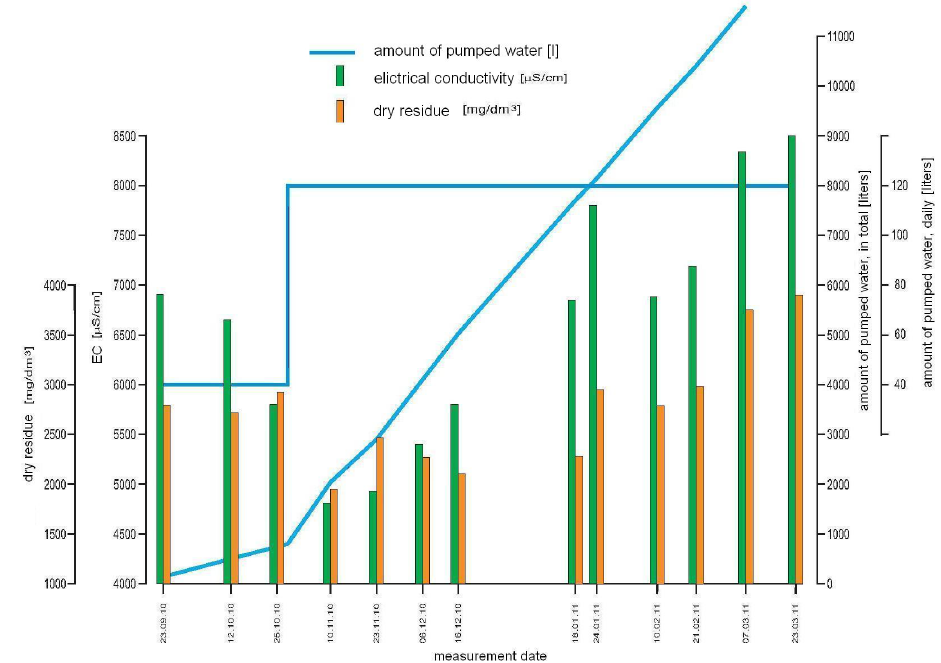
Figure 5. Changes of EC, dry residues, and the amount of pumped water at the landfill site (daily and in